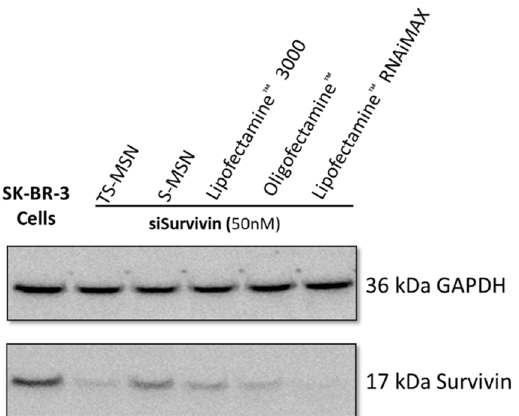
Figure 5. Western blot image of Survivin protein expression on SK-BR-3 cells transfected with TS- MSN, S-MSN, and commercial transfection agents formulated with siSurvivin (50 nM) compared to non-treated cells. TS-MSN: targeted stealth magnetic siRNA nanovectors, S-MSN: stealth magnetic siRNA nanovectors, GAPDH: glyceraldehyde 3-phosphate dehydrogenase.